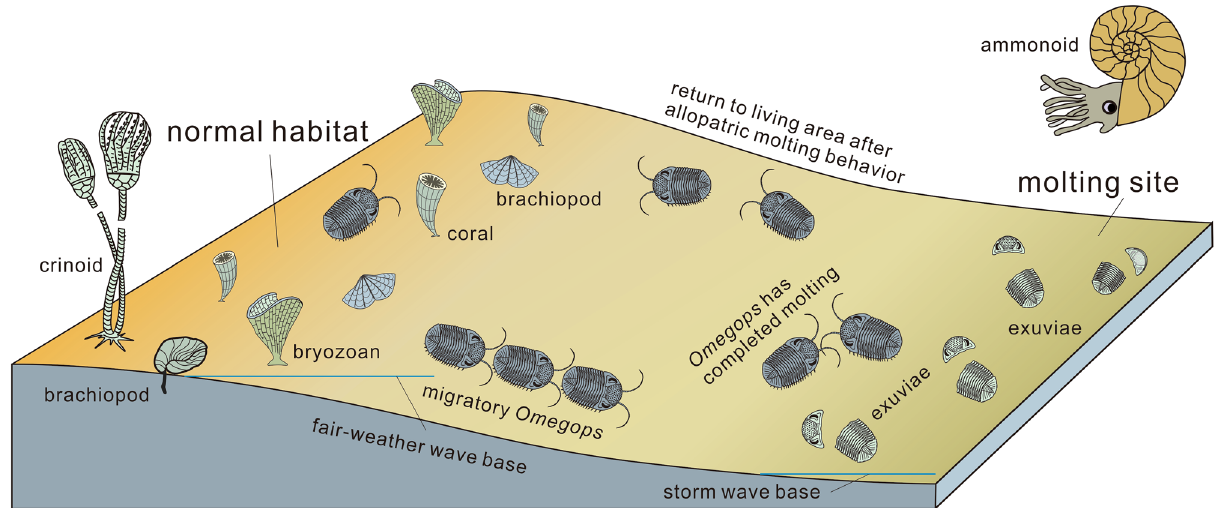
Figure 5. Schematic diagram of the allopatric molting of the Late Devonian trilobite Omegops sp. A in western